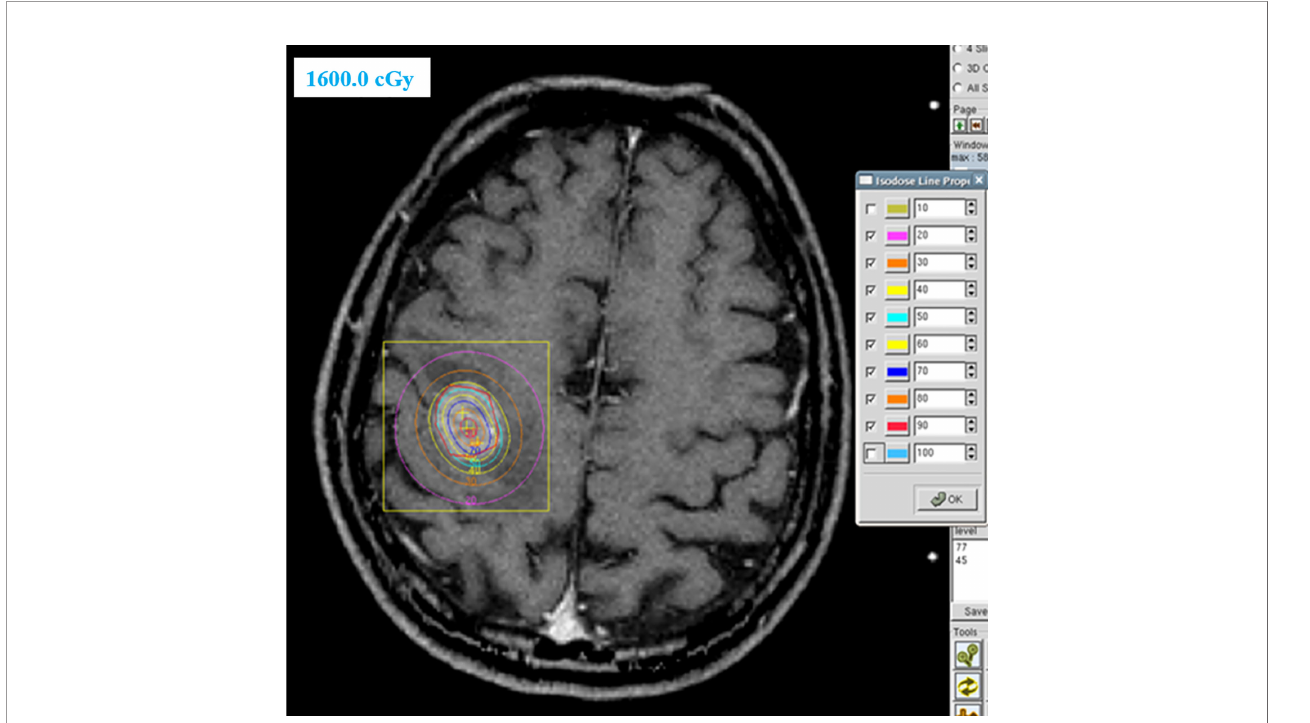
FIGURE 1 | Patient with single metastasis received stereotactic